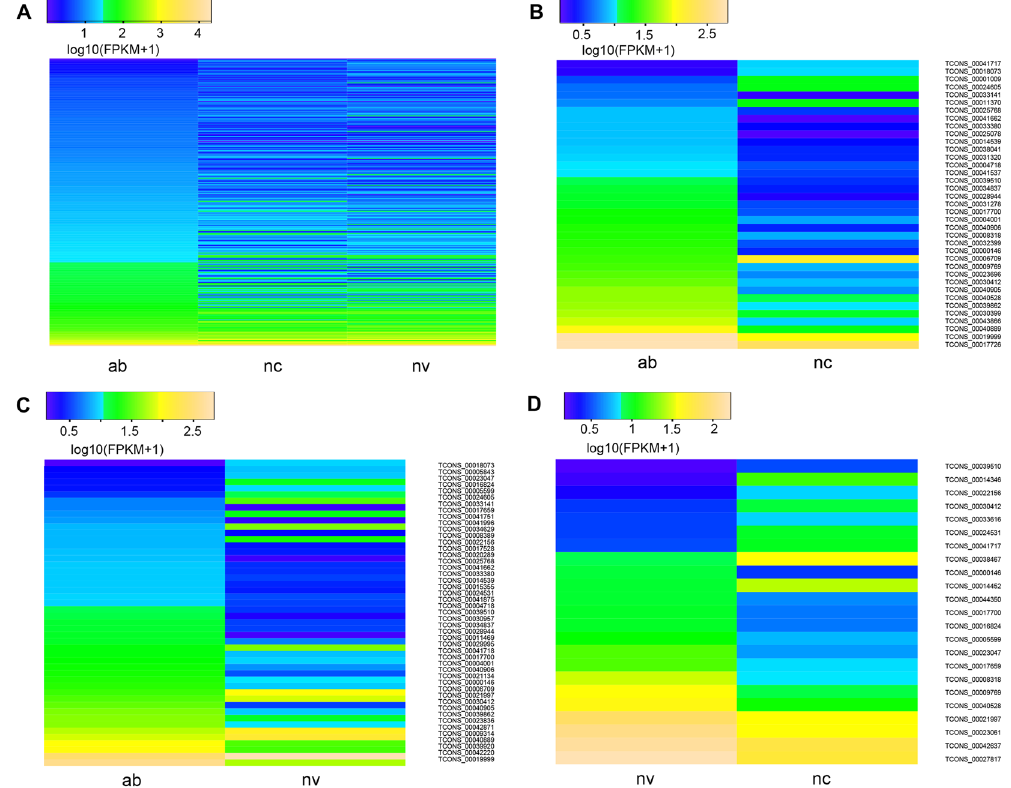
Figure 4. Expression of lincRNAs in different groups. Shown are heat maps of the log 10 transformed FPKM + 1 expression values for differentially expressed lincRNAs. The density of the color scheme is calibrated to the log 10 expression level, such that yellow refers to higher expression while blue refers to lower expression. The bar code represents the color scale of the log 10 (FPKM + 1). ab: the ab group; nc: the nc group; nv: the nv group. ( A ) All lincRNAs expression in three groups; ( B ) 37 differentially expressed lincRNAs between the ab group and the nc group; ( C ) 48 differentially expressed lincRNAs between the ab group and the nv group; ( D ) 23 differentially expressed lincRNAs between the nv group and the nc group.